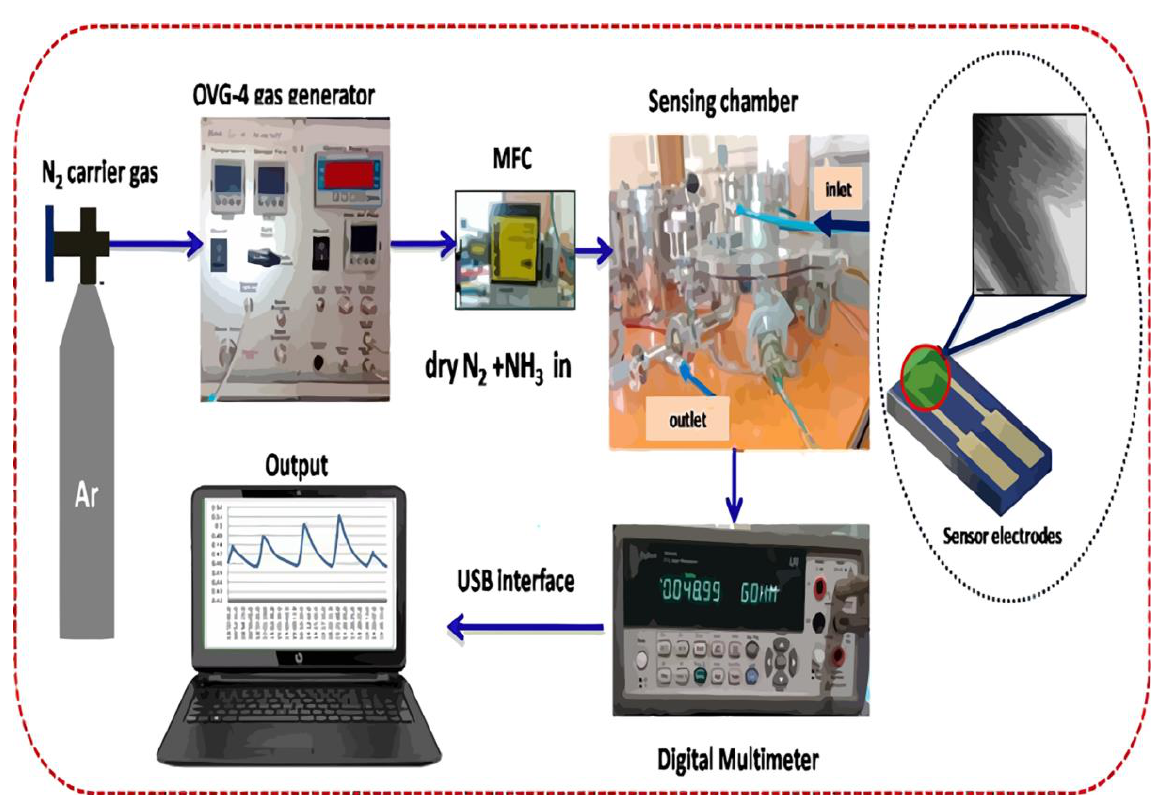
Figure 3. A schematic illustration of the experimental setup used for NH 3 gas sensing measure- ments.